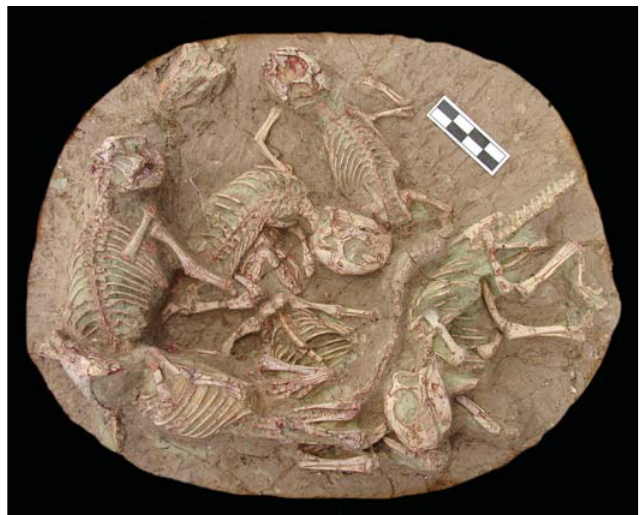
Fig. 1. The cluster of hatchling ceratopsian dinosaur Psittacosaurus lujia- tunensis Zhou, Gao, Fox, and Chen, 2006 (IVPP V16902) from western Liaoning, China, Early represented at each growth stage. Comparisons between different limb bones in each stage are also demonstrated.